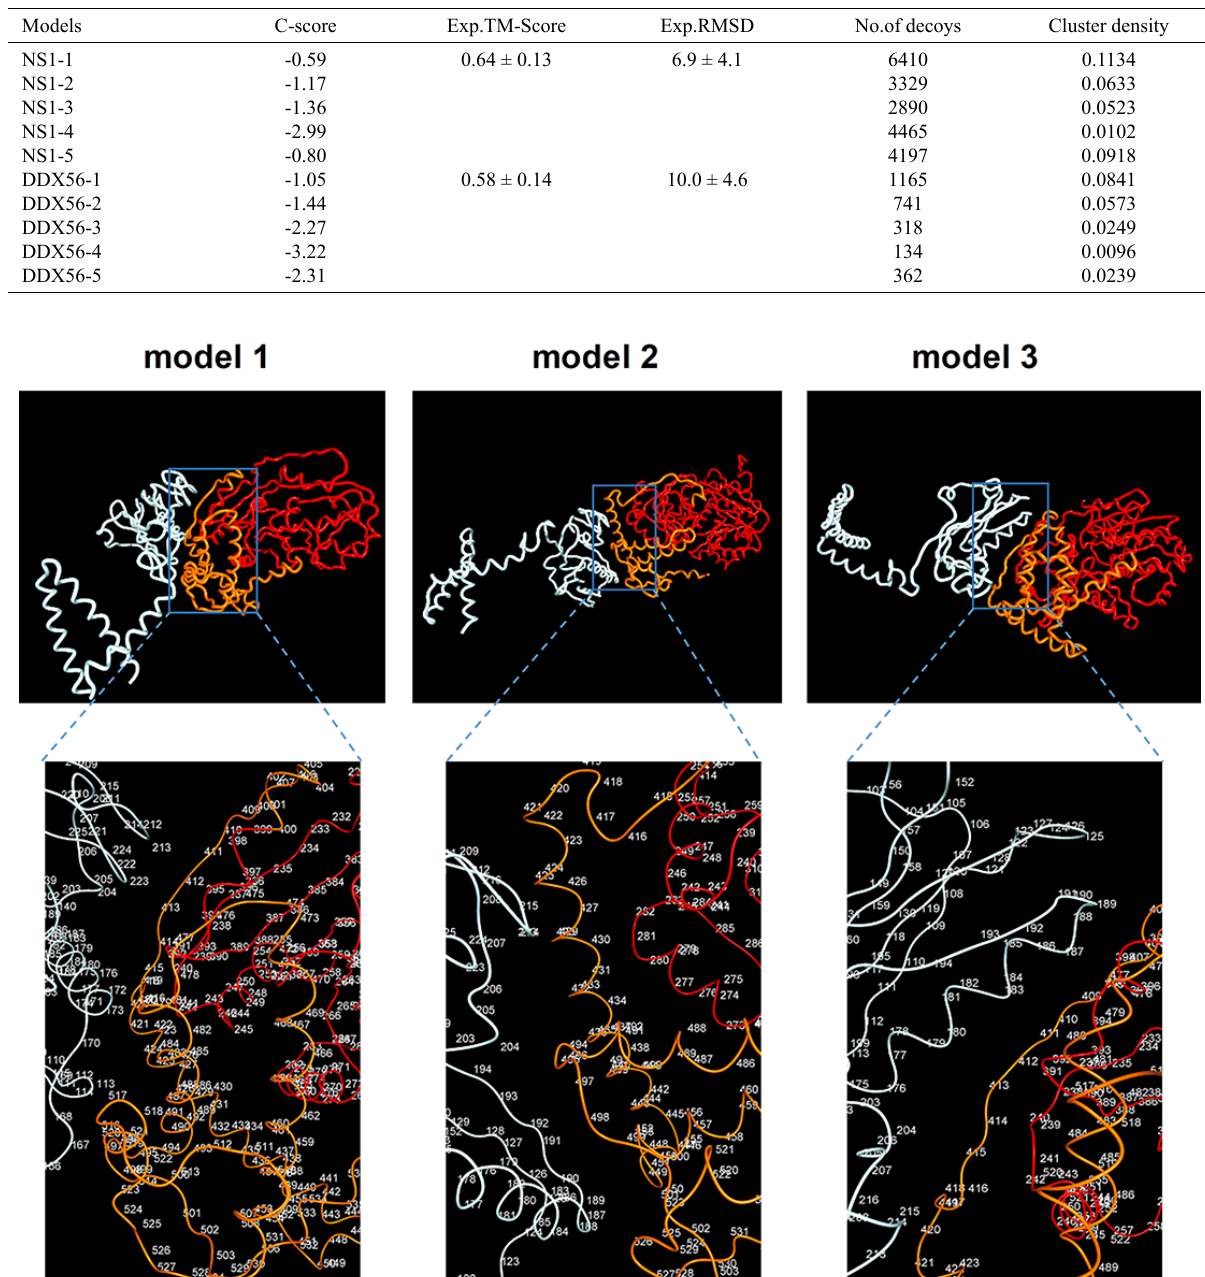
Table 2 – C-scores for predicted 5 top NS1 and DDX56 models.